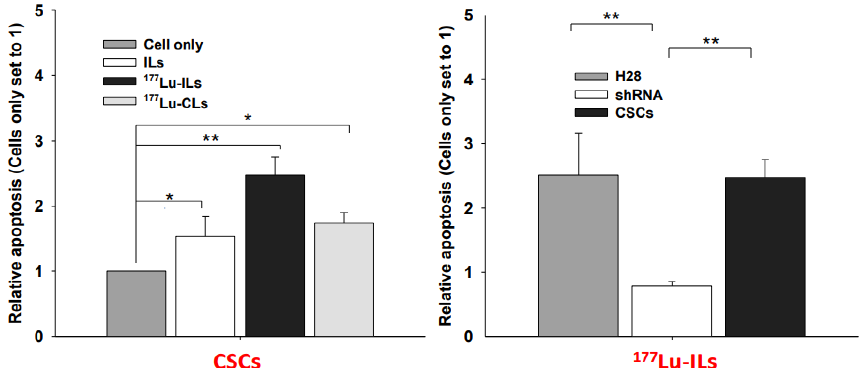
Figure 8. Induced apoptosis in MM cells treated with 177 Lu-ILs or 177 Lu-CLs. Left panel: MM CSCs were treated with 177 Lu-IL or 177 Lu-CL for 1 h. Control was treated with media alone or ILs only. The media were replaced with fresh media and further incubated for 48 h. Apoptosis was assessed using a Cell Death Detection ELISA PLUS and calculated by setting untreated CSCs as 1. Right panel: MM cells treated with 177 Lu-ILs were compared with untreated cells. Mean ± SD ( n = 3), p < 0.05 (*), and p < 0.01